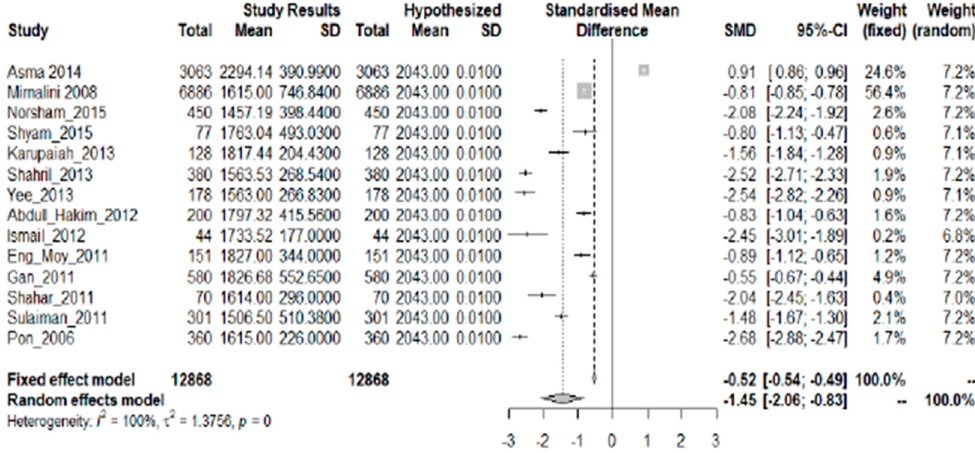
Figure 2. Meta-analysis of studies on energy intake of Malaysian Figure 2. Meta ‐ analysis of studies on energy intake of Malaysian adults.